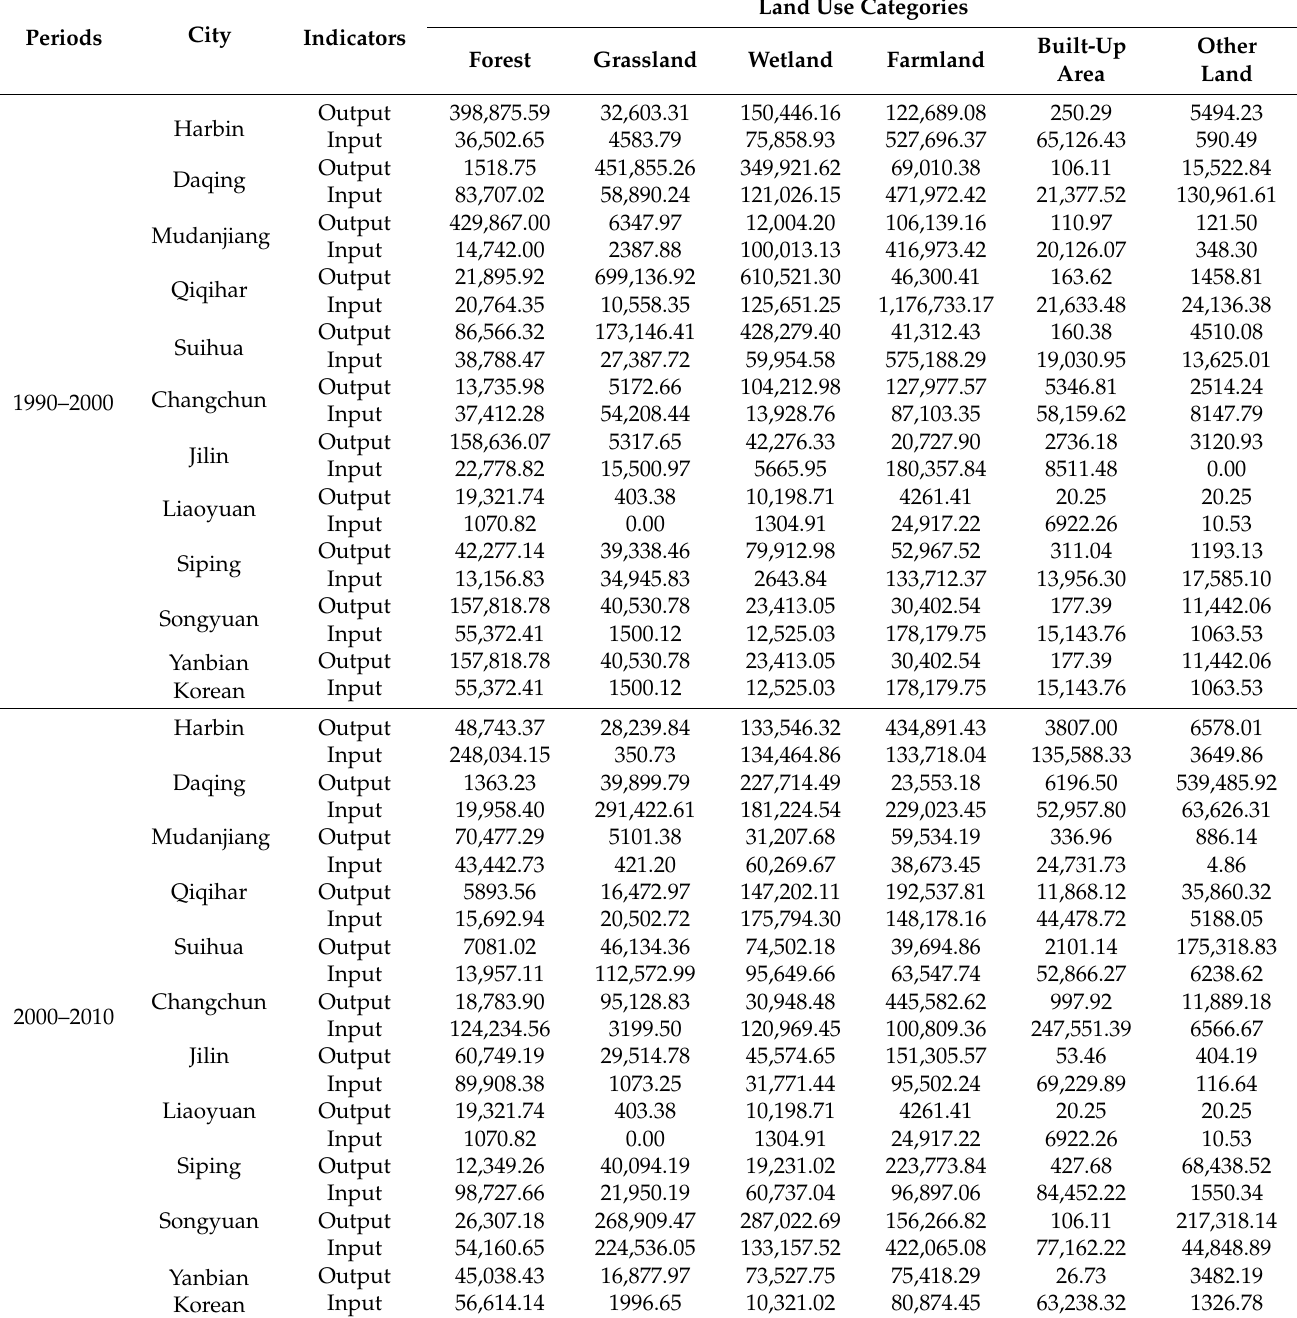
Table A1. Output and input degrees of nodes in different